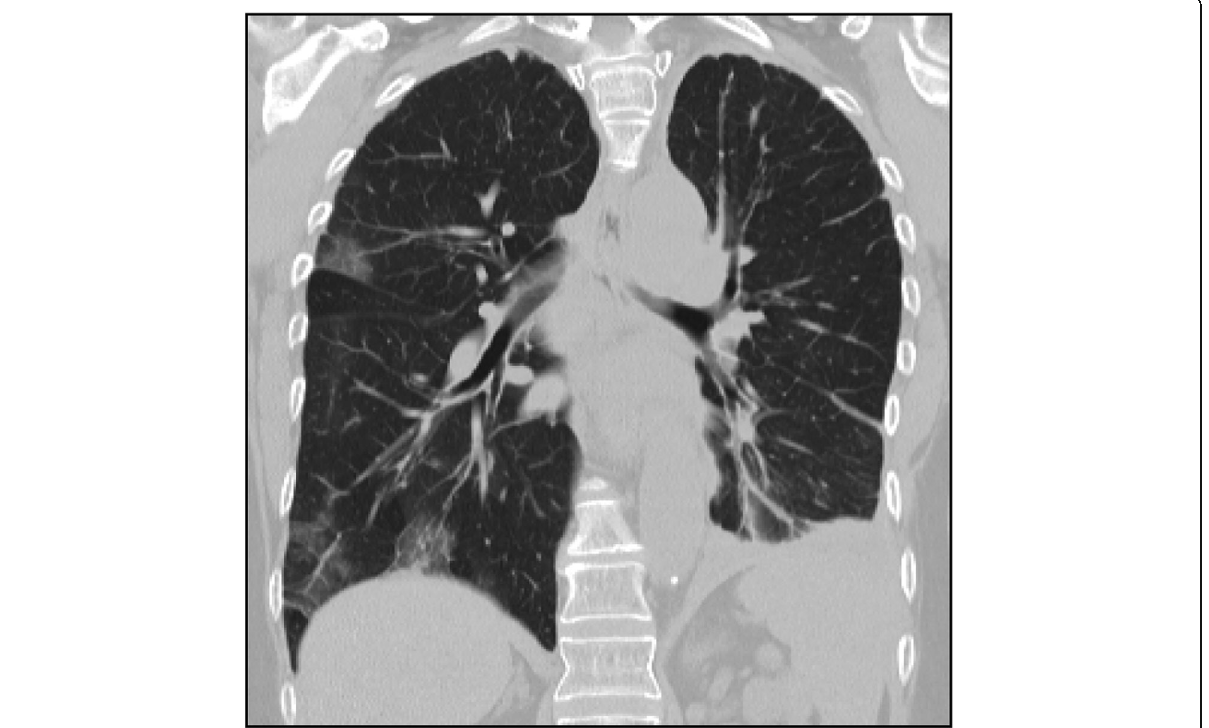
Fig. 6 Female patient 70 years old with COVID-19. CT coronal image shows peripheral ground glass opacities with vascular thickening in the right lung. Note the left mild pleural